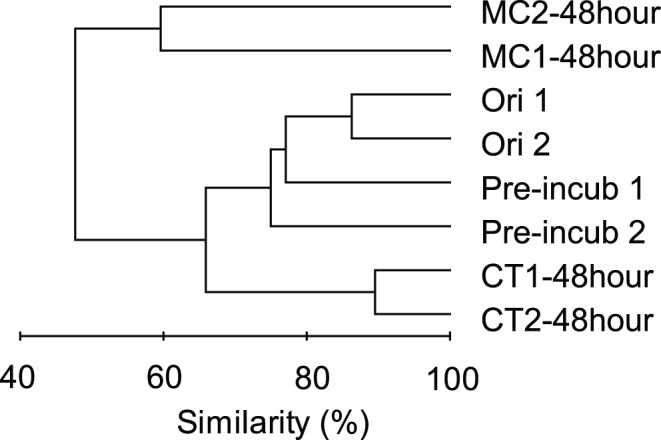
Clustering pattern of bacterioplankton 16S rRNA gene contents based on T-RFLP analysis.Cluster analysis of T-RFLP data for original water samples (Ori 1 and 2), samples at the end of inorganic nutrient pre-incubation (Pre-incub 1 and 2) and samples at the end of MC-LR incubation experiments in the microcystin amended (MC1–48 h and MC2–48 h) and control (CT1–48 h and CT2–48 h) microcosms.